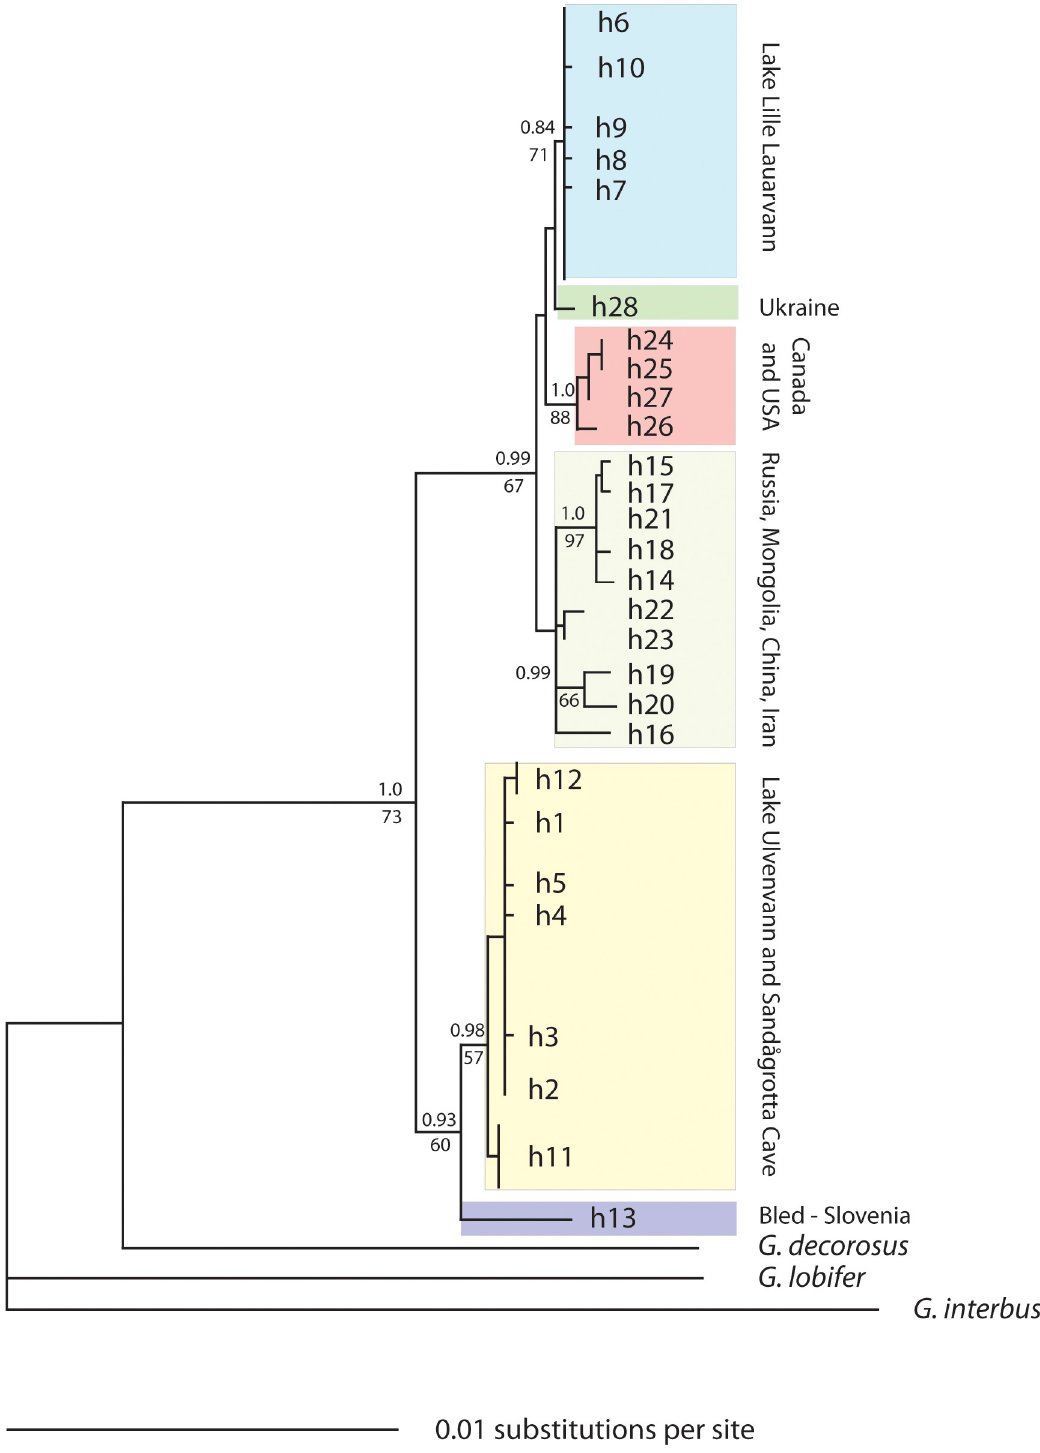
Fig 5. Consensus mtDNA-COI gene tree with bootstrap support provided. Maximum likelihood bootstrap (above) and Bayesian support (below)). The location codes are as follows: LL = Lake Lille Lauarvann, SC = Sand å grotta Cave, and LU = Lake